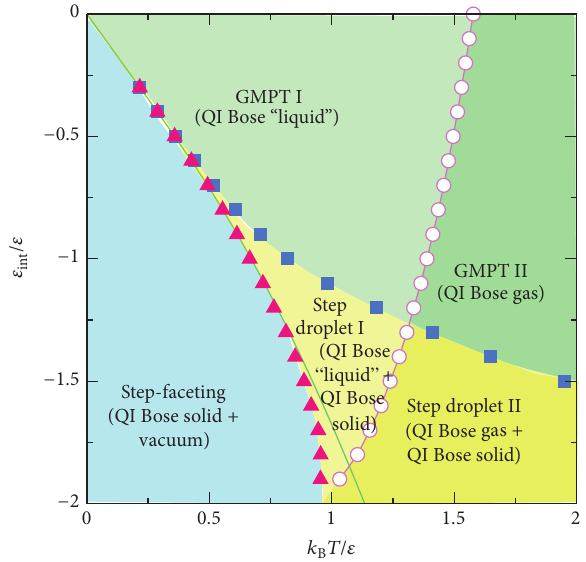
Figure 3: Faceting diagram of the p-RSOS model for a vicinal surfaceobtainedbytheDMRGmethod. Squares: calculated 𝑇 𝑓,1 . For 𝑇 < 𝑇 𝑓,1 , the surface tension is discontinuous (disconnected, more precisely) around the (111) surface. Triangles: calculated 𝑇 𝑓,2 . For 𝑇 < 𝑇 𝑓,2 , the surface tension is discontinuous around the (001) surface. Open circles: calculated roughening transition temperatures of the (001) surface. Solid line: zone boundary line calculated by the two- dimensional Ising model. For the definition and details about QI Bose solid, QI Bose liquid, and QI Bose gas, refer to [5]. This figure is taken from